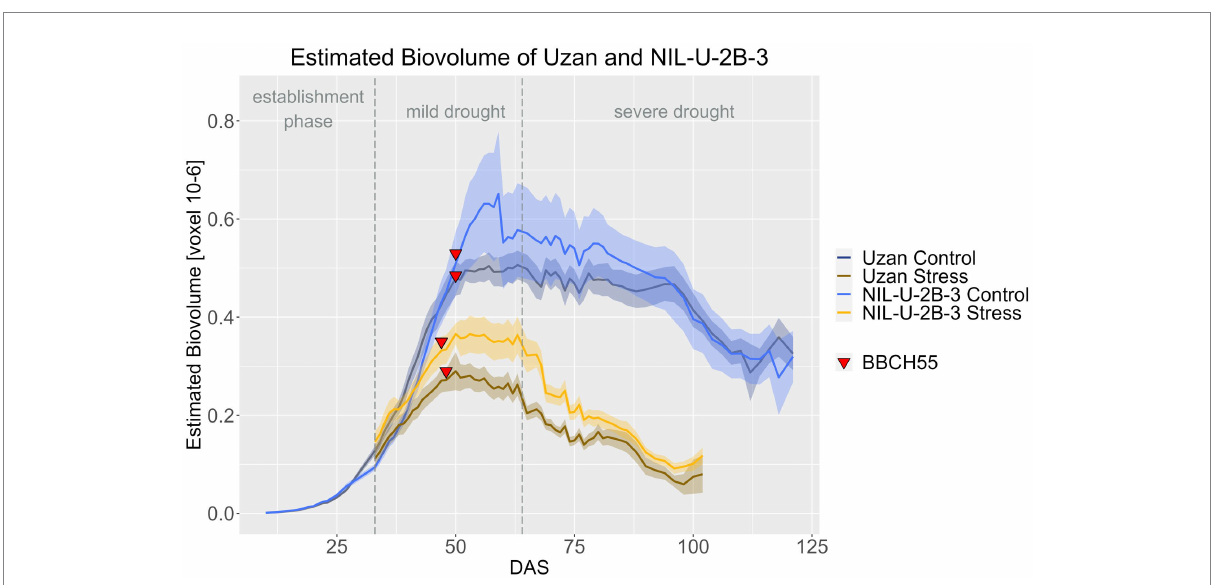
FIGURE 9 Color value of Uzan and NIL-U-2B-3 based on calculated BLUEs values.DAS, days after sowing; BBCH55, heading day. The last DAS for each genotype was chosen for the DAS where the last time 60% of the plants were imaged (as mature plants were taken off subsequently). The shadows describe the confidence interval; as long as the shadows of the individual lines do not overlap, the significance level of a = 0.05 is not reached and therefore a significant difference exists.